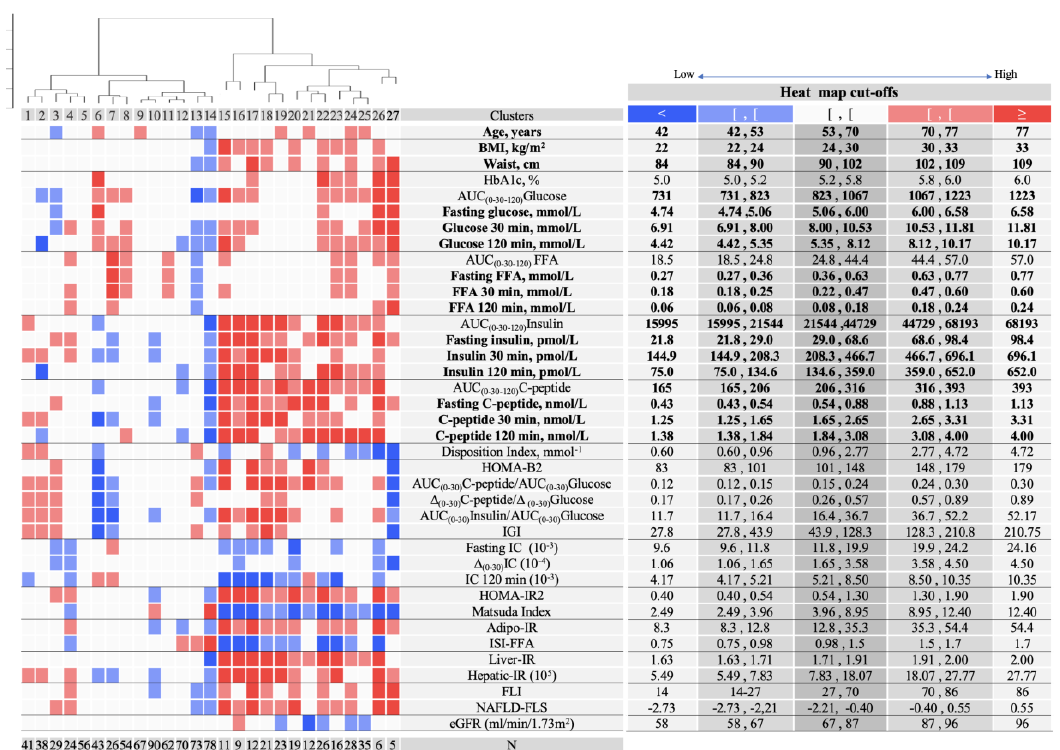
Figure 3. Clusters profiling for K = 27. Clusters were profiled with several parameters and the median of each cluster was compared with the distribution of the overall population (percentiles 10th, 25th, 75th, and 90th), and are displayed with a heatmap scale. The colors are defined by comparing the cluster median of the parameters with the distribution of the overall population (10th, 25th, 75th, and 90th percentiles). The table on the right shows the quantile limit values for each profiling parameter. Number of subjects in each cluster is displayed below the heatmap (N). AUC-Area under the curve; BMI-Body mass index; eGFR-CKD-estimated glomerular filtration rate using the Chronic Kidney Disease Epidemiology Collaboration (CKD-EPI) formula: FLI-Fatty liver Index; IC-Insulin clearance; IGI-Insulinogenic index; IR-Insulin resistance.